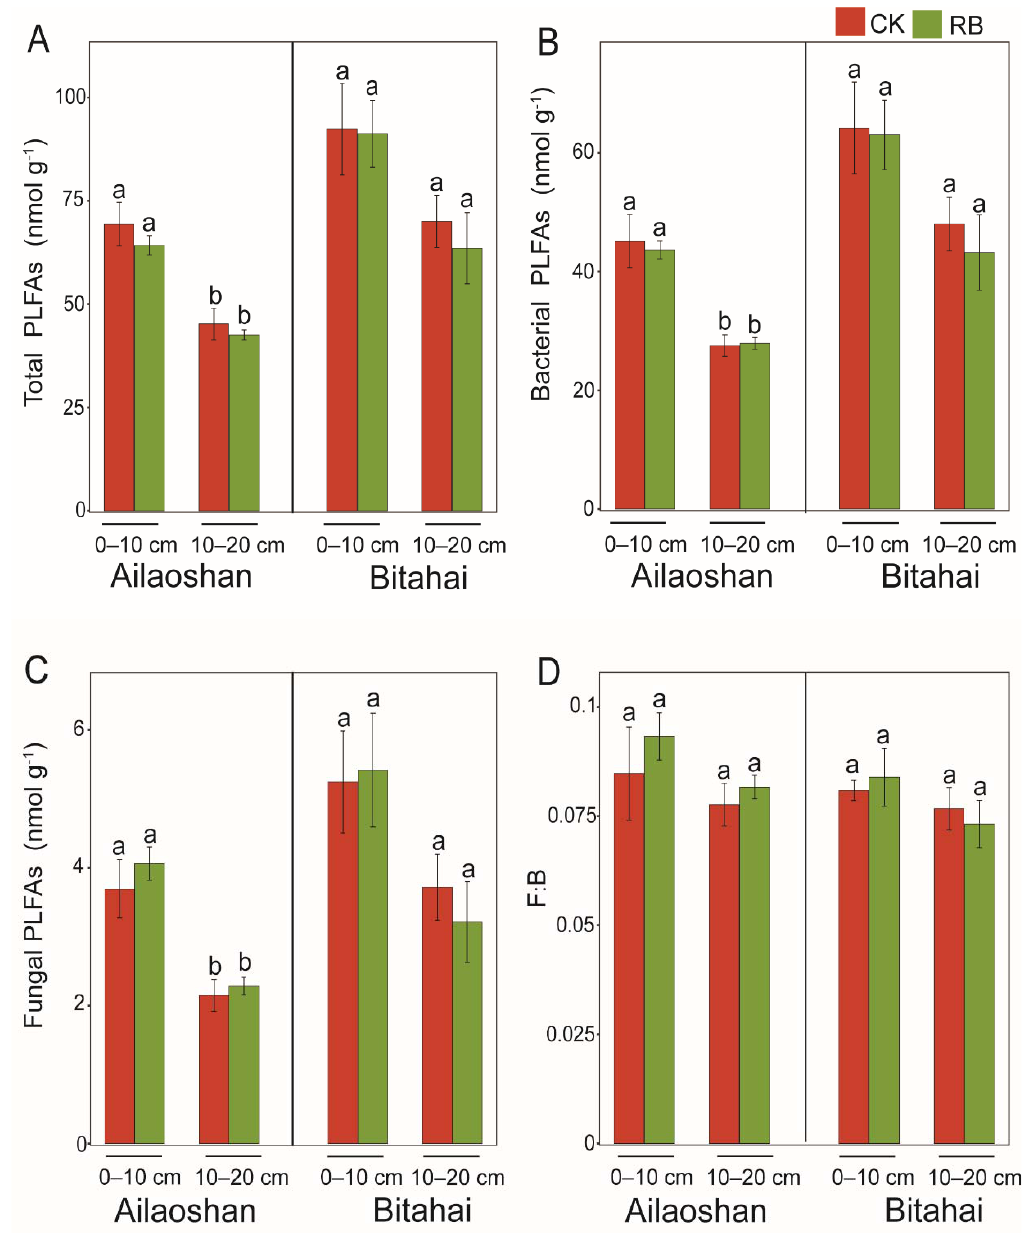
Figure 3. Effects of bryophyte removal (CK: bryophytes not removed; BR: bryophytes removed) and soil depth (0–10 and 10–20 cm) on soil microbial PLFAs in Ailaoshan and Bitahaiu. ( A ): total PLFAs, ( B ): bacterial PLFAs, ( C ): bacterial PLFAs, ( D ): the ratio of fungal and bacterial PLFAs. Values are the means ± SE of six plots. Different lowercase letters mean significant differences at P < 0.05 between treatments.